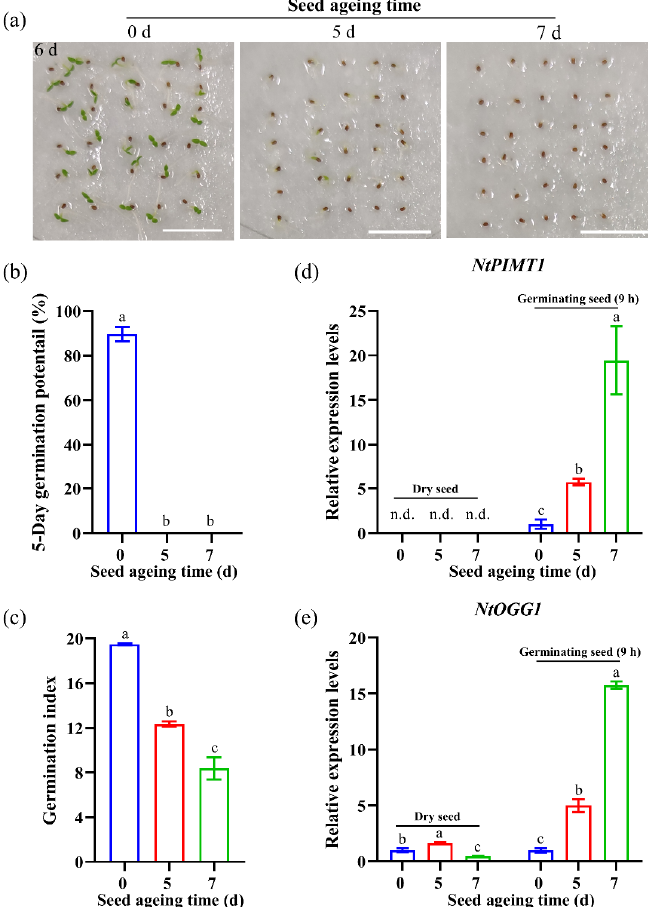
Figure 3. Characteristics of seed vigour and NtPIMT1 and NtOGG1 expression in non-pelleted seeds of tobacco cultivar ‘Yunyan 87 ′ after artificial ageing treatments. ( a ) Representative images of ger- mination at 6 d under 25 °C conditions in seeds after 0- (CK), 5- and 7-day ageing treatments. Scale bars = 10 mm. ( b ) Germination potential; ( c ) germination index. Expression patterns of ( d ) NtIPMS1 and ( e ) NtOGG1 in dry and germinating (9 d) seeds. Data are means (±SD), n = 3. Different letters above the column indicate significant differences determined using ANOVA test: p < 0.01. 3.4. Expression Patterns of NtPIMT1 and NtOGG1 in Pelleted Seeds after Artificial Ageing Treatments To further determine the correlations between NtPIMT1 and NtOGG1 expression and the degree of seed damage, the pelleted seeds were further used for artificial ageing treat- ments. Significantly lower germination potential and germination index were observed in seeds after 1 and 3 days of artificial ageing treatments compared to those in unaged seeds (0 d; CK) (Figure 4a–c). qRT-PCR results indicated that the mRNA levels of NtPIMT1 and NtOGG1 in dry seeds gradually and significantly increased with the increasing degree of